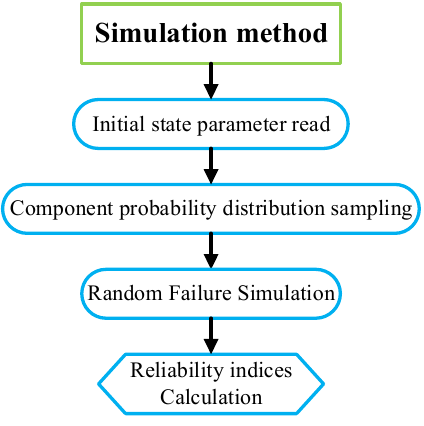
Figure 4. Flow chart of simulation method.